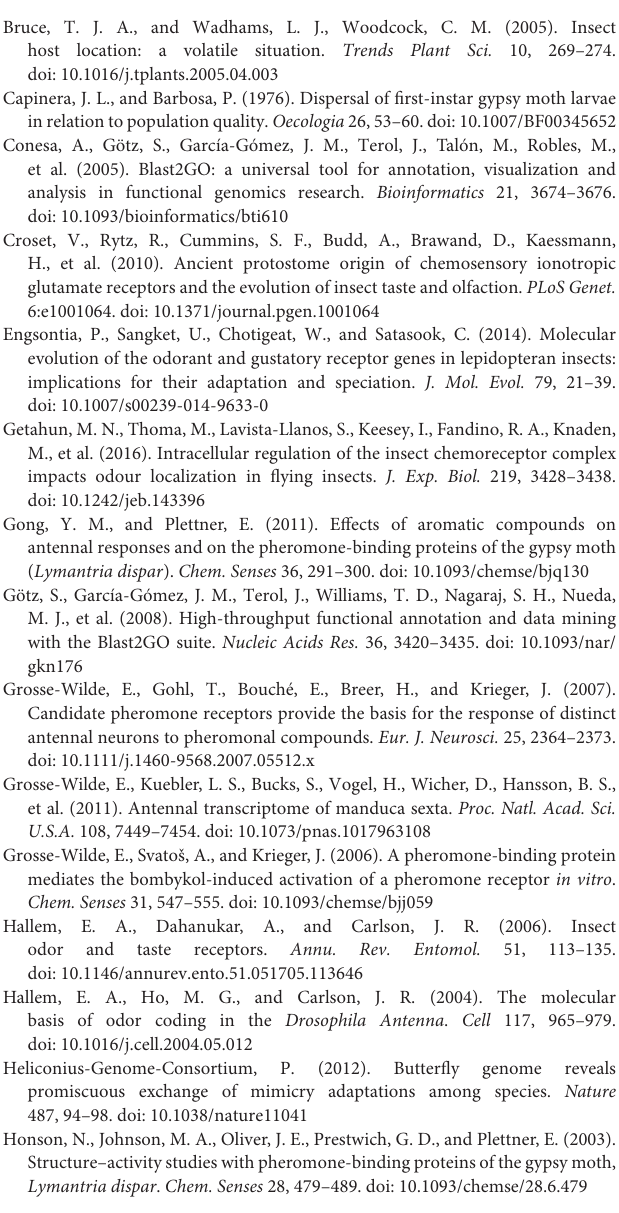
Supplementary Figure 1 | Percent of Bombyx mori protein recovery in a blast search for three subspecies of the Gypsy moth ( L. dispar ). The flight capable AGM (Asian gypsy moth) and JGM (Japanese gypsy moth), and the flightless EGM (European gypsy